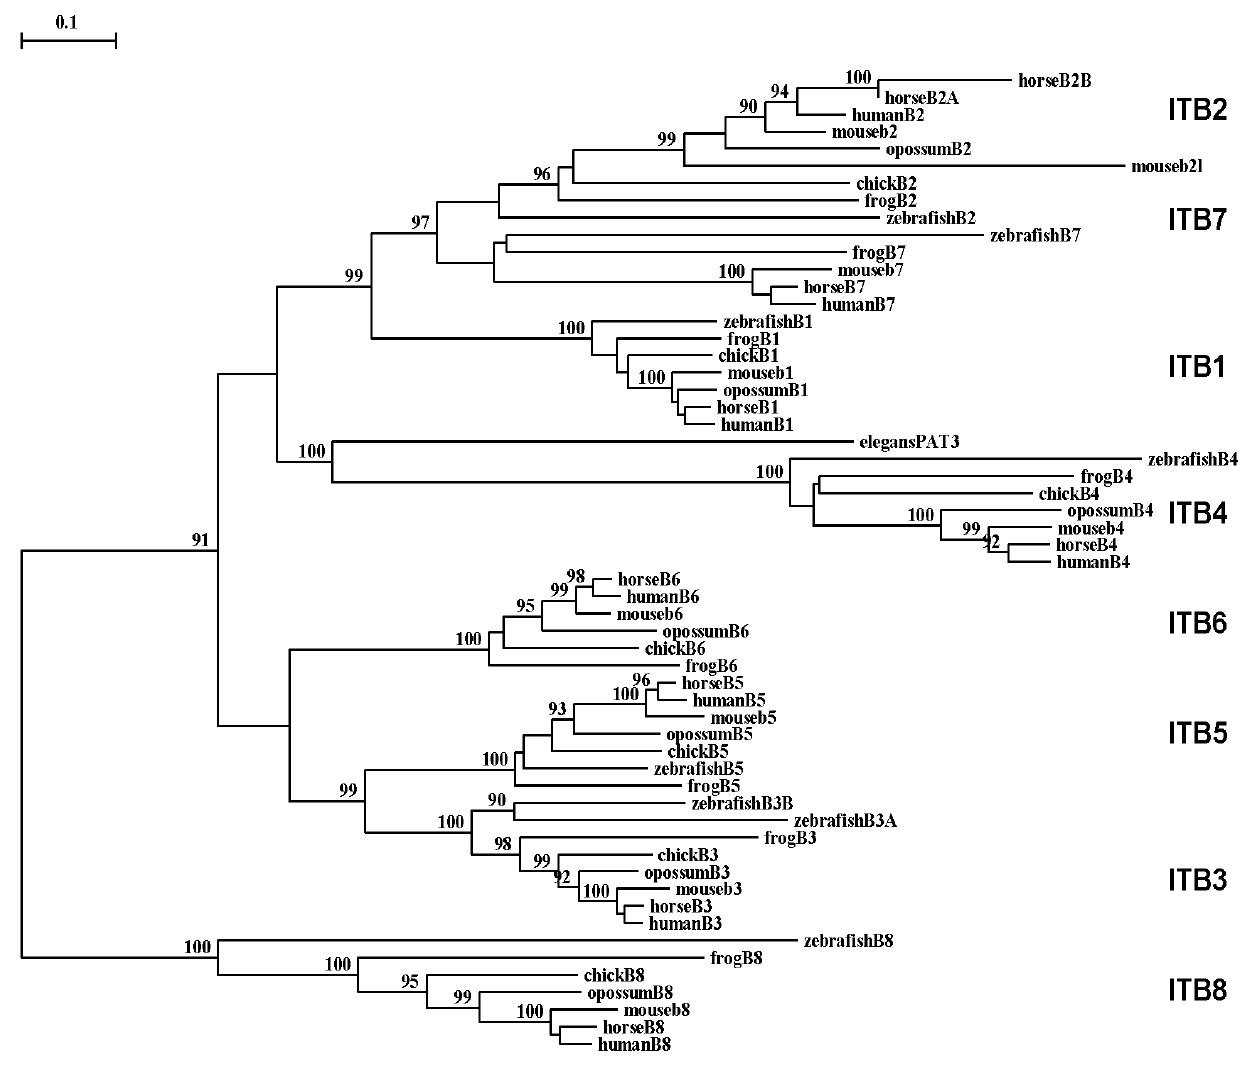
Figure 6. Phylogenetic tree of vertebrate beta integrin cytosolic domain amino acid sequences. The tree is labeled with the ITB name and the name of the animal and is ‘rooted’ with the Caenorhabitis elegans (nematode) ITB-like sequence (see Table 1). Note the 7 major clusters corresponding to the ITB1 , ITB2 , ITB3 , ITB4 , ITB5 , ITB6 , ITB7 and ITB8 gene families. A genetic distance scale is shown (% amino acid substitutions). The number of times a clade (sequences common to a node or branch) occurred in the bootstrap replicates are shown. Only replicate values of 90 or more which are highly significant are shown with 100 bootstrap replicates performed in each